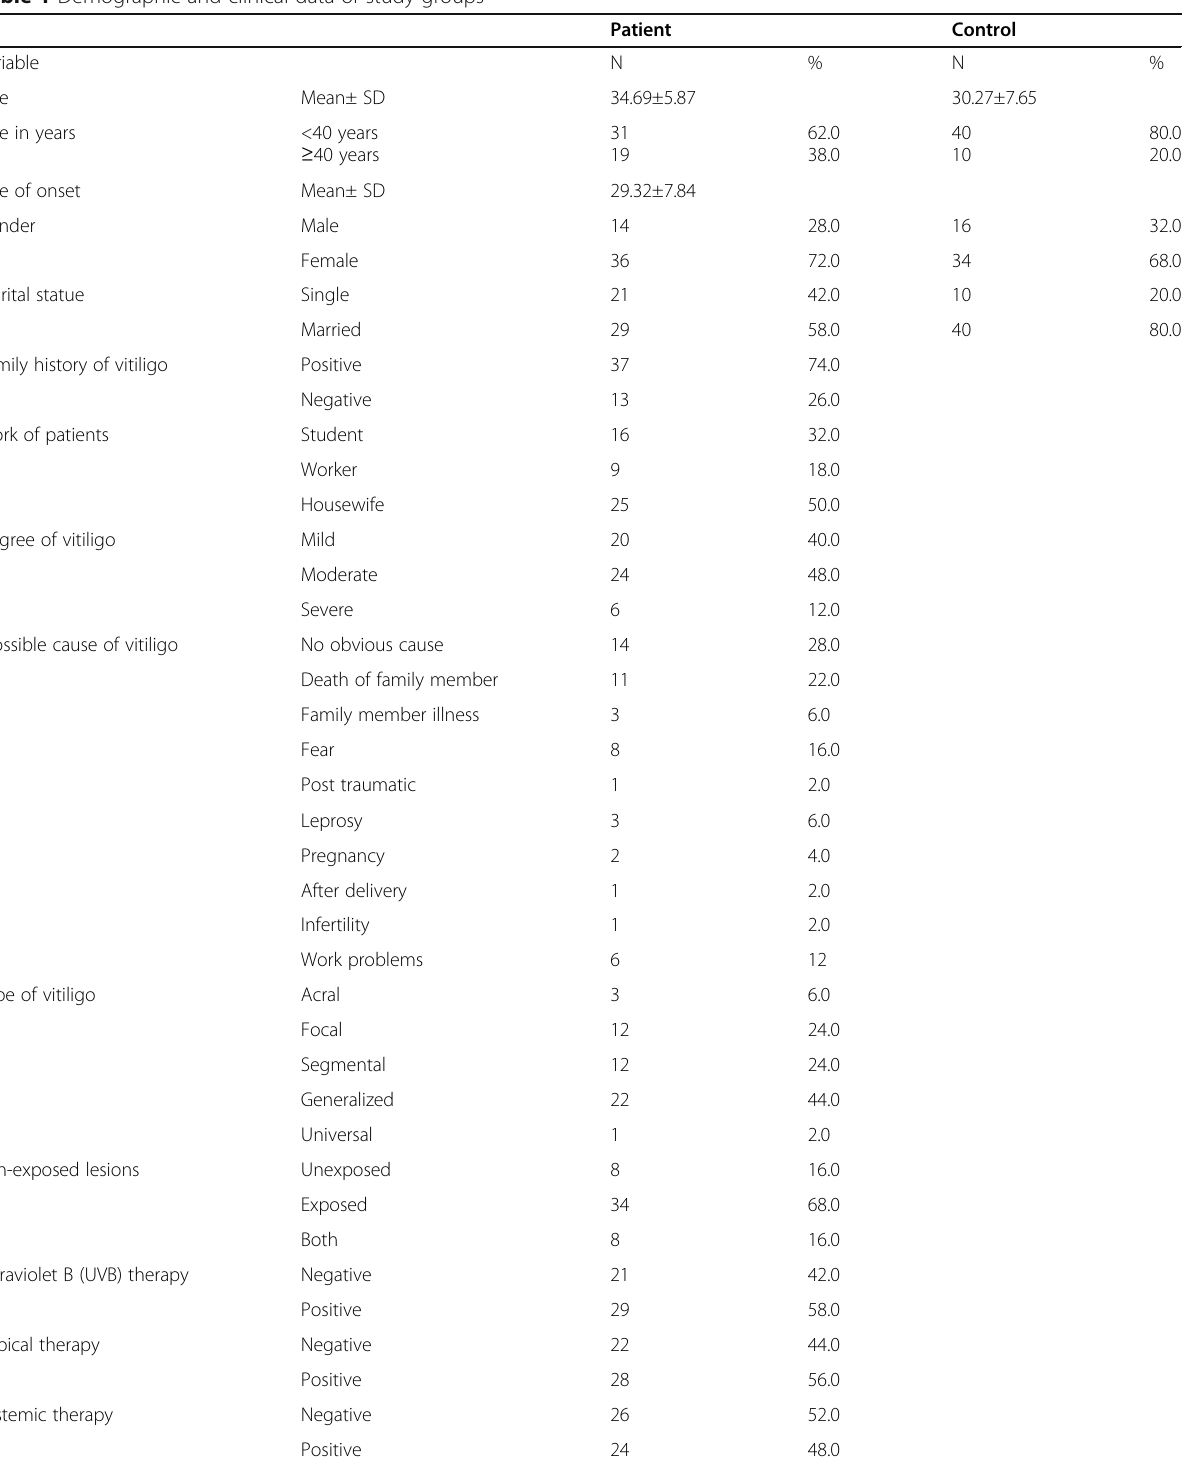
Table 1 Demographic and clinical data of study groups